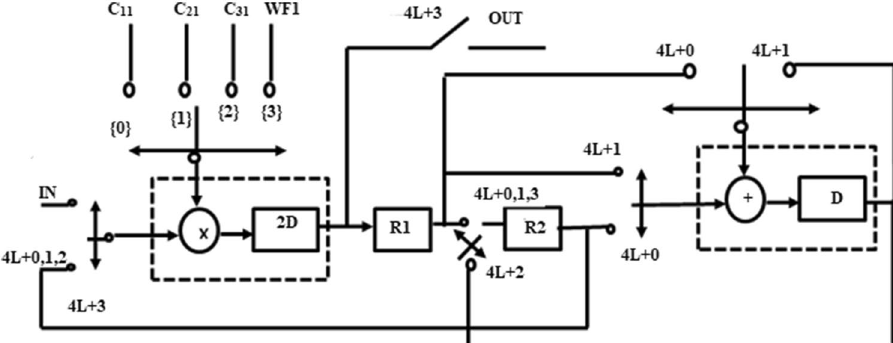
Figure 9. Folded structure of Block1 of GLRT.